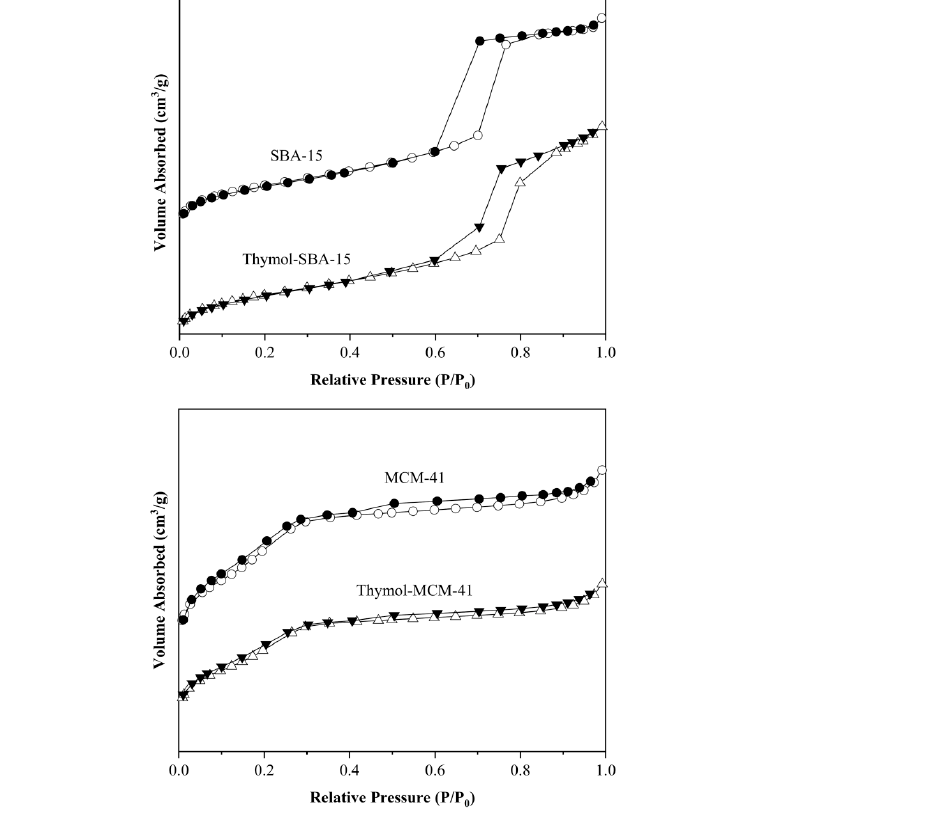
Figure 5. N 2 adsorption/desorption isotherms of MCM-41, SBA-15, Thy-MCM-41, and Thy-SBA-15.